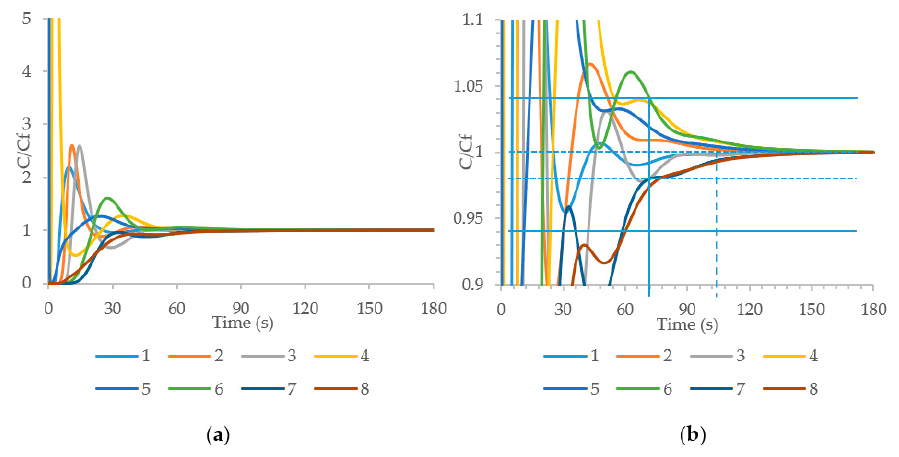
Figure 11. Normalized mass fraction curves when using a flow rate of 1.30 L · min − 1 and a 135 ◦ plug angle. ( a ) Normalized value in whole range. ( b ) Normalized value between 0.9 and 1.1.